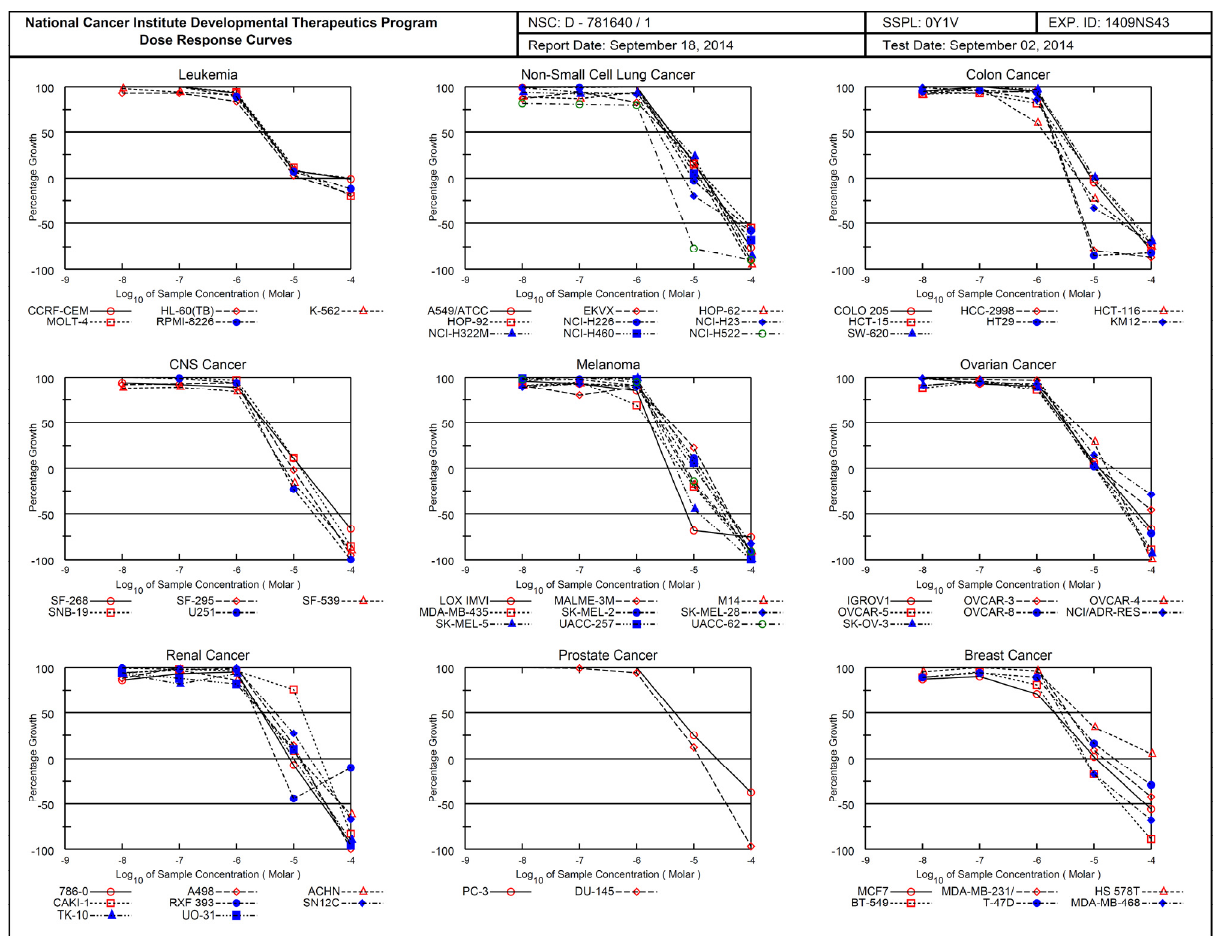
Figure 4. The mean GI 50 for compound C2 and curcumin (Cur) in µM concentration.